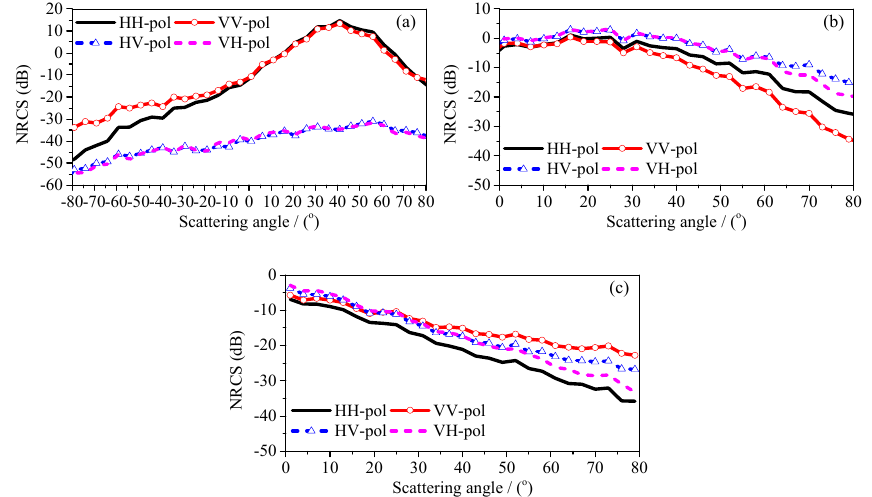
Figure 11. Bistatic NRCS evaluated by FPFSM on the variation of scattering angles. ( a )